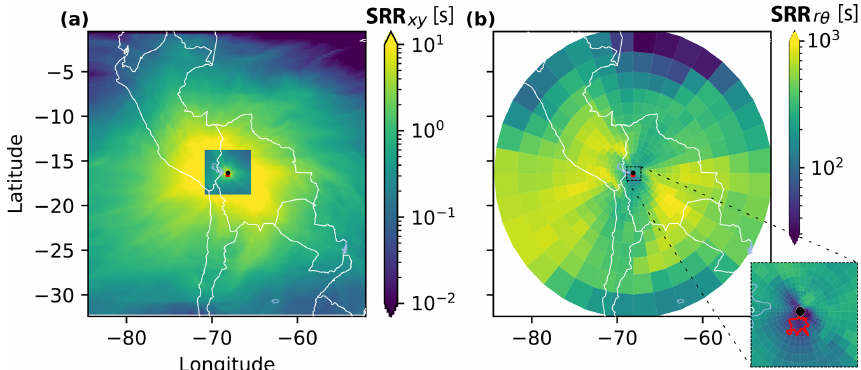
Figure 3. Rectangular and log-polar surface plots of the SRR from December 2017 to May 2018. In (a) the mean rectangular SRR SRR xy = (cid:80) (cid:80) t SRR xyzt , and in (b) the man log-polar SRR SRR rθ = (cid:80) z z n t area of La Paz–El Alto.